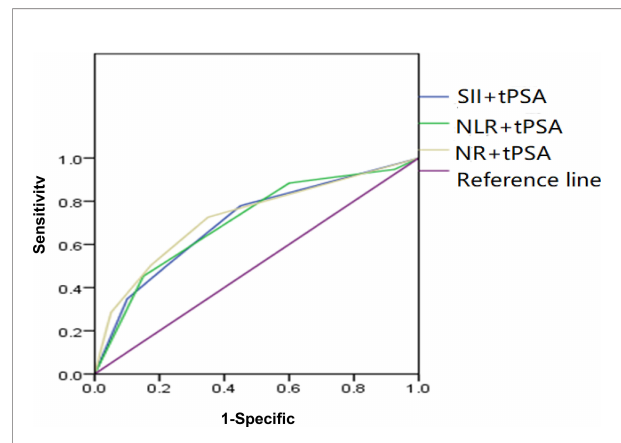
FIGURE 3 | ROC analysis of SII, NLR, and NR combined with tPSA. SII + tPSA got the largest AUC of 0.725, the second was NLR + tPSA with an AUC of 0.705, and the third was NR + tPSA with an AUC of